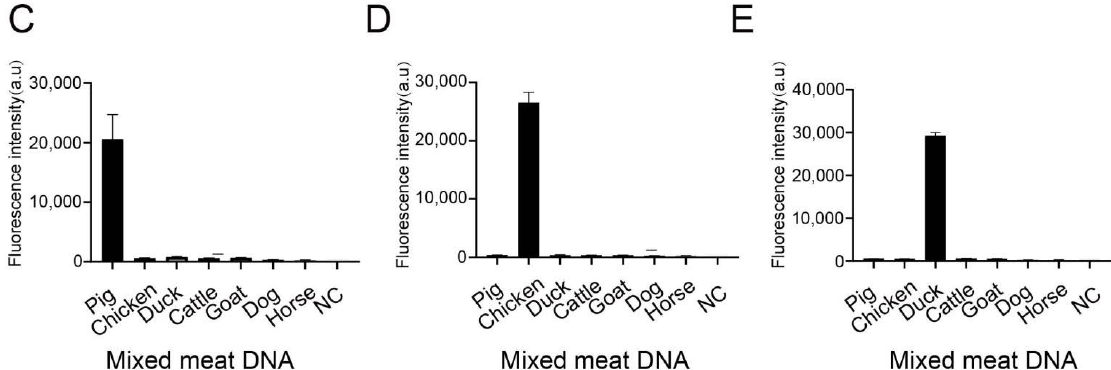
Figure 3. Establishing a naked-eye colorimetric CRISPR/Cas12a assay and assessing the specificity of pork, chicken and duck meat detection. ( A ) Comparison of colorimetric and fluorescence signal of JOE- and Texas Red-labelled ssDNA reporters. ( B ) Assessment of the specificity of LAMP combined with a naked-eye colorimetric CRISPR/Cas12a technology. ( C – E ) The end-point signal intensity from Figure 3B was further measured using a fluorescence microplate reader. DNA template represents LAMP amplification of NADH4, DN2 or D-Loop genes. Texas Red stands for Texas Red-labelled ssDNA reporter , JOE stand for JOE-labelled ssDNA reporter; and NC stands for negative control. Data are represented as means ± SEM; n = 3.